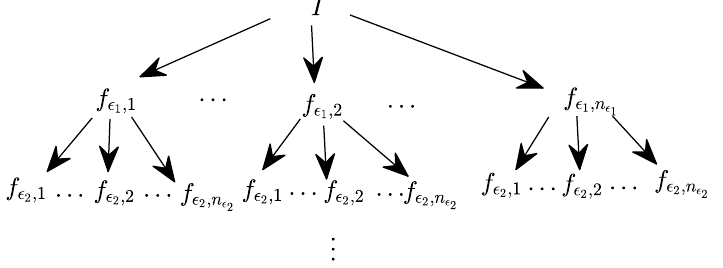
Figure 3. The tree structure of the function system F (cid:101) with certain choice of (cid:101)